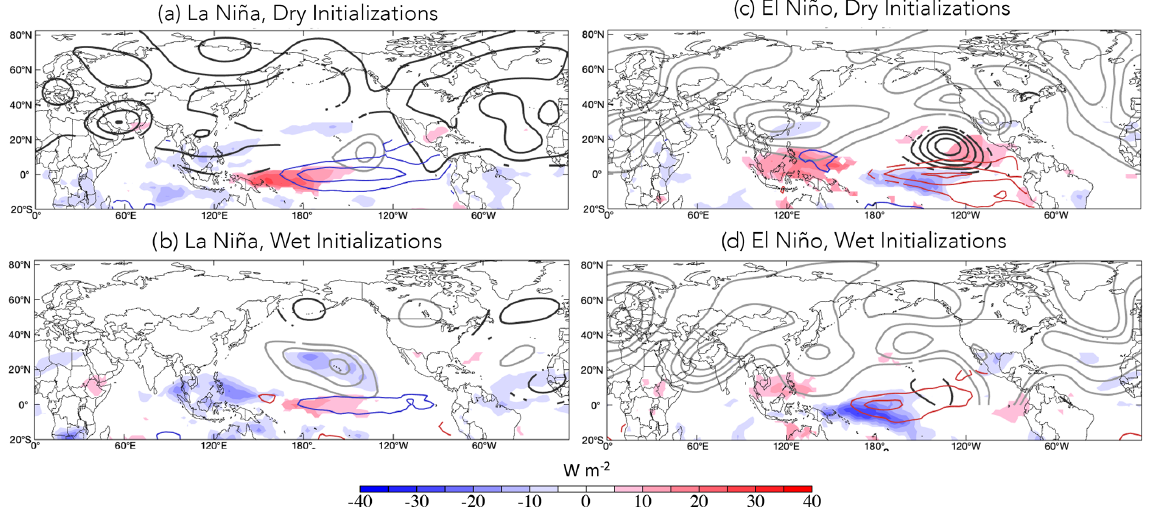
Figure 11. As in Fig. 10 but for groups divided by Niño3.4 < 0 (“La Niña”) or Niño3.4 > 0 (“El Niño”) and with negative SST anomalies in blue contours and positive SST anomalies shown in red, at a contour interval of 0.5 ◦